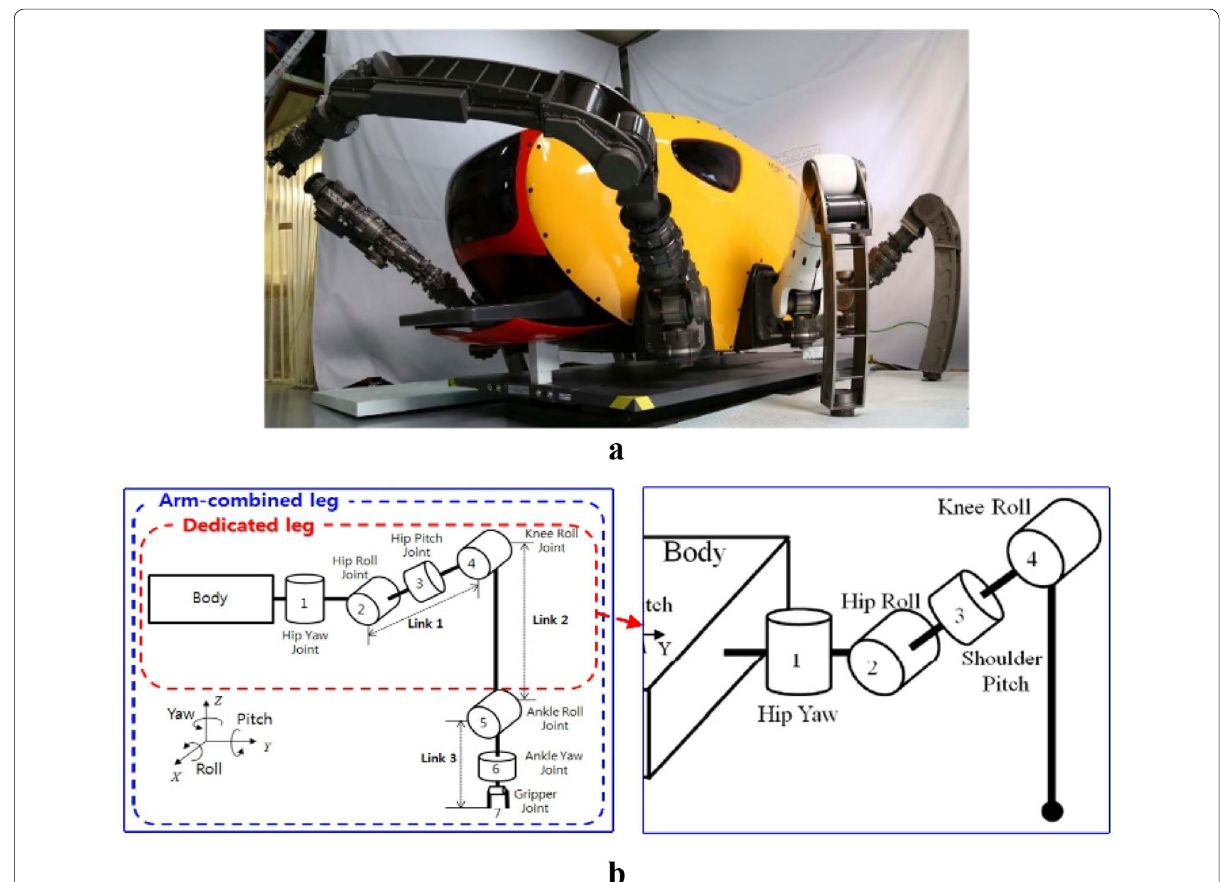
Figure 7 a The Crabster200 hexapod robot [32]; b arm-combined leg mechanism [33]